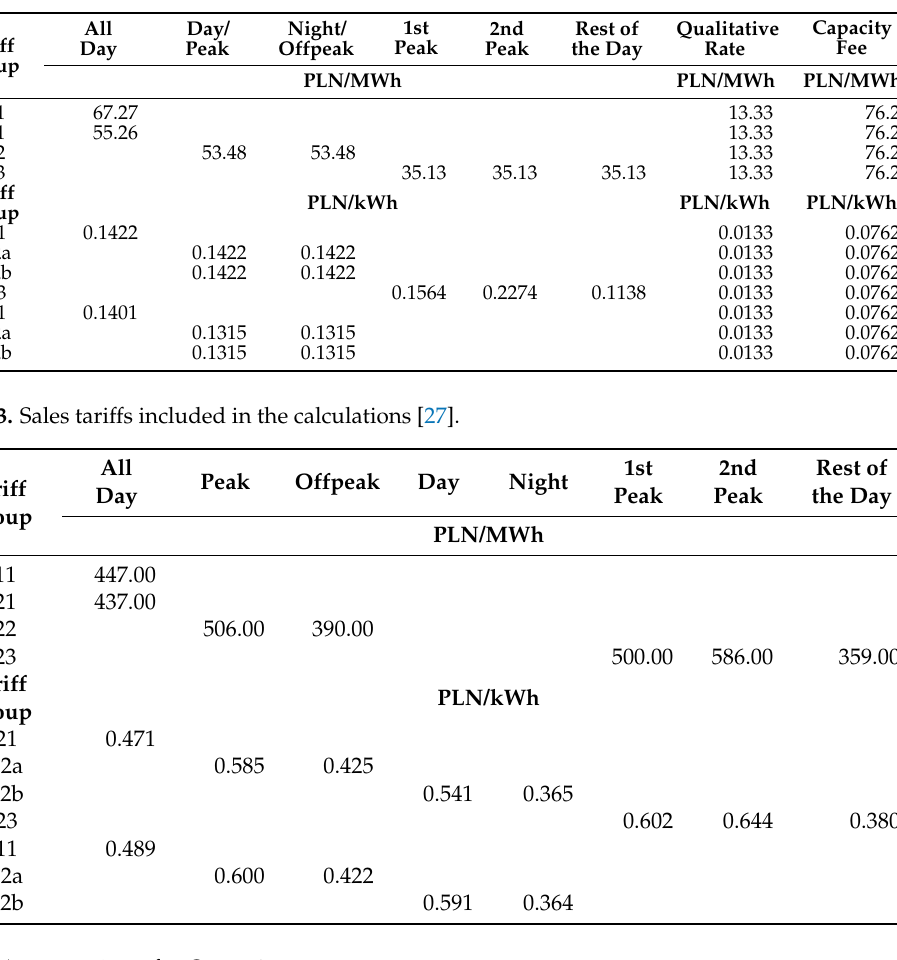
Table 2. Distribution tariffs included in the calculation [26].